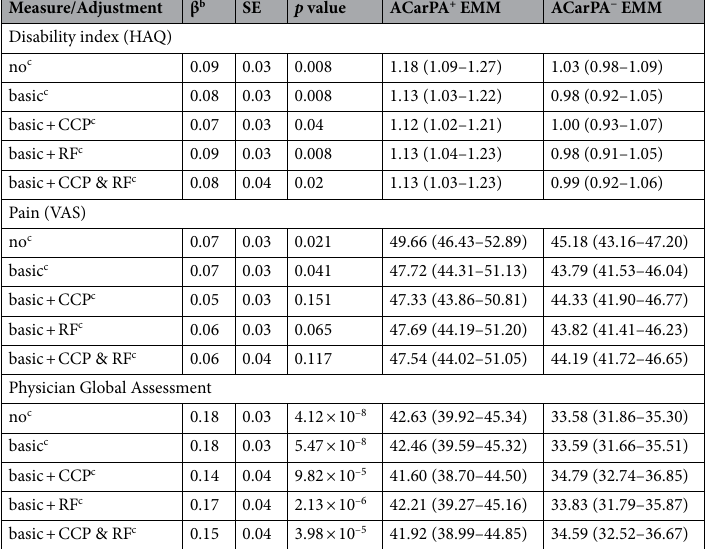
Table 4. Increased disability, pain and physician global assessment in the ACarPA + patients at baseline a . a Data from 949, 966 and 903 patients were available for the first-row analysis of the HAQ, VAS and PhGA analyses, respectively. The remaining analyses counted with 99% of these patients. b The results are presented as in the Table 2. c The analyses were performed as in the Table